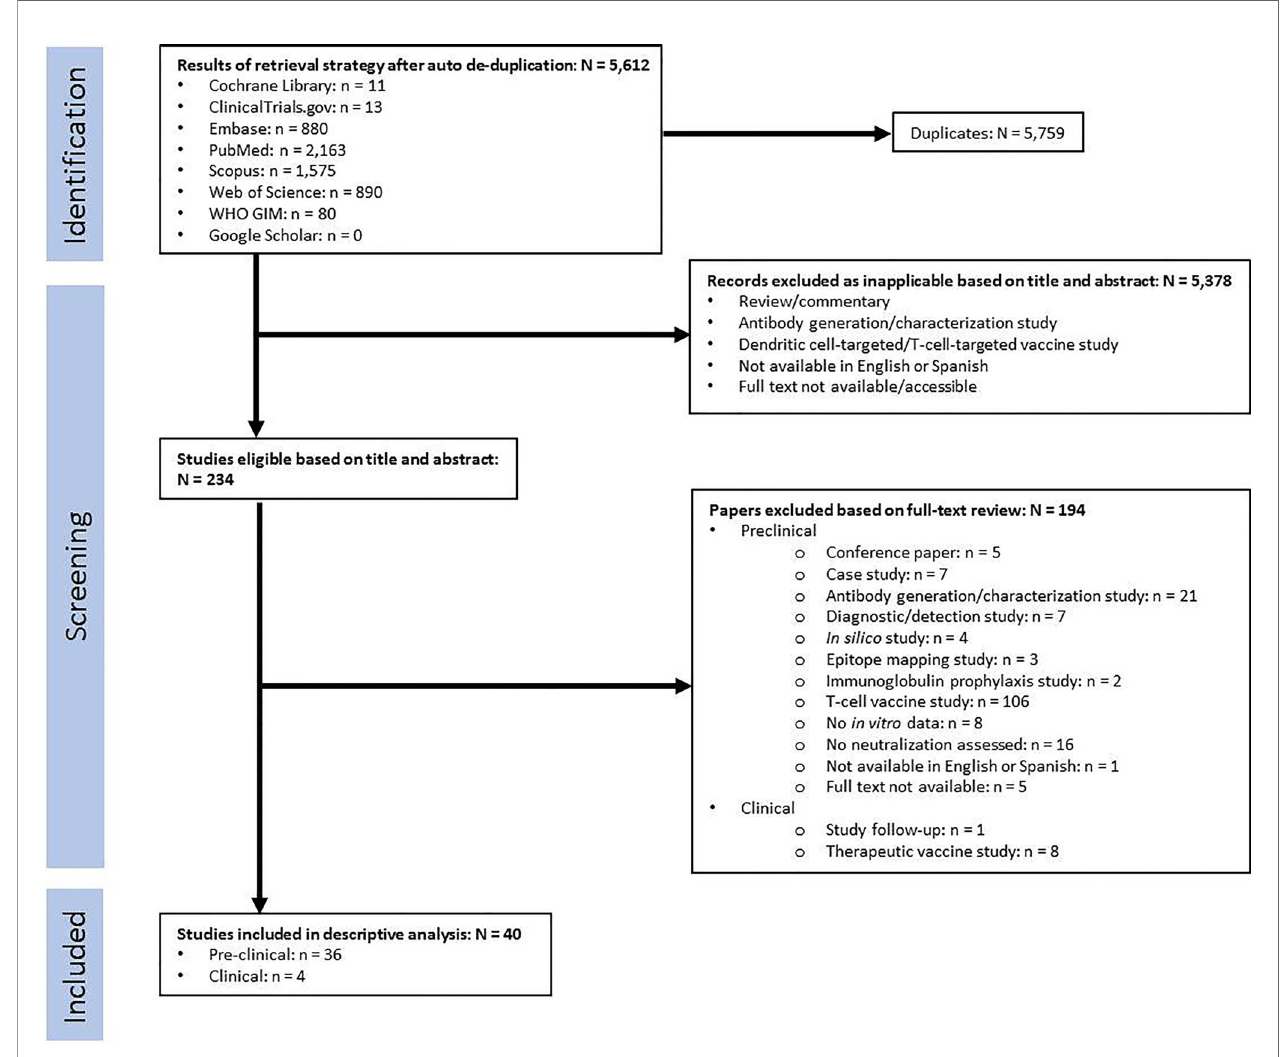
FIGURE 2 | Flow chart for study